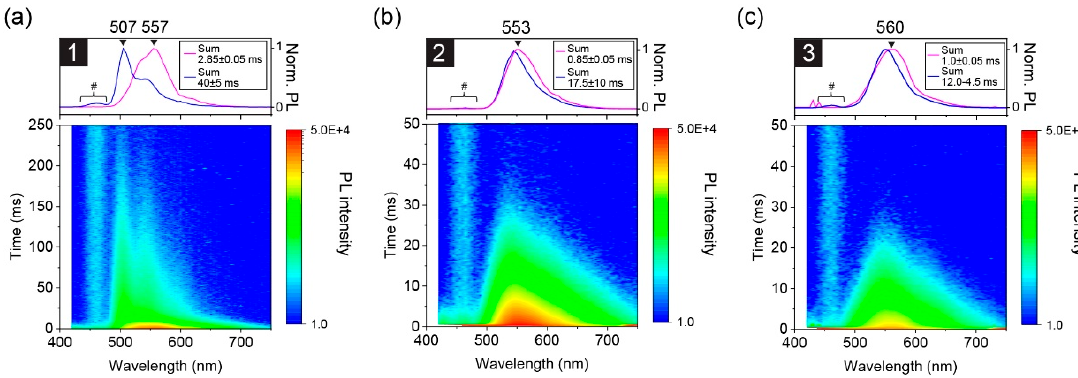
Figure 4. Time-resolved PL spectra of ( a ) 1 , ( b ) 2 , and ( c ) 3 at 77 K measured using the multichannel scaler (MCS) method: (top) Intensity summed PL spectra taken at time regions depicted in each graph legend, (bottom) contour map of the time-resolved results. The excitation light source was a pulsed LED at 355 nm. The region marked with a hash (#) is a background feature attributed to scattering by the sample cell containing solvent.